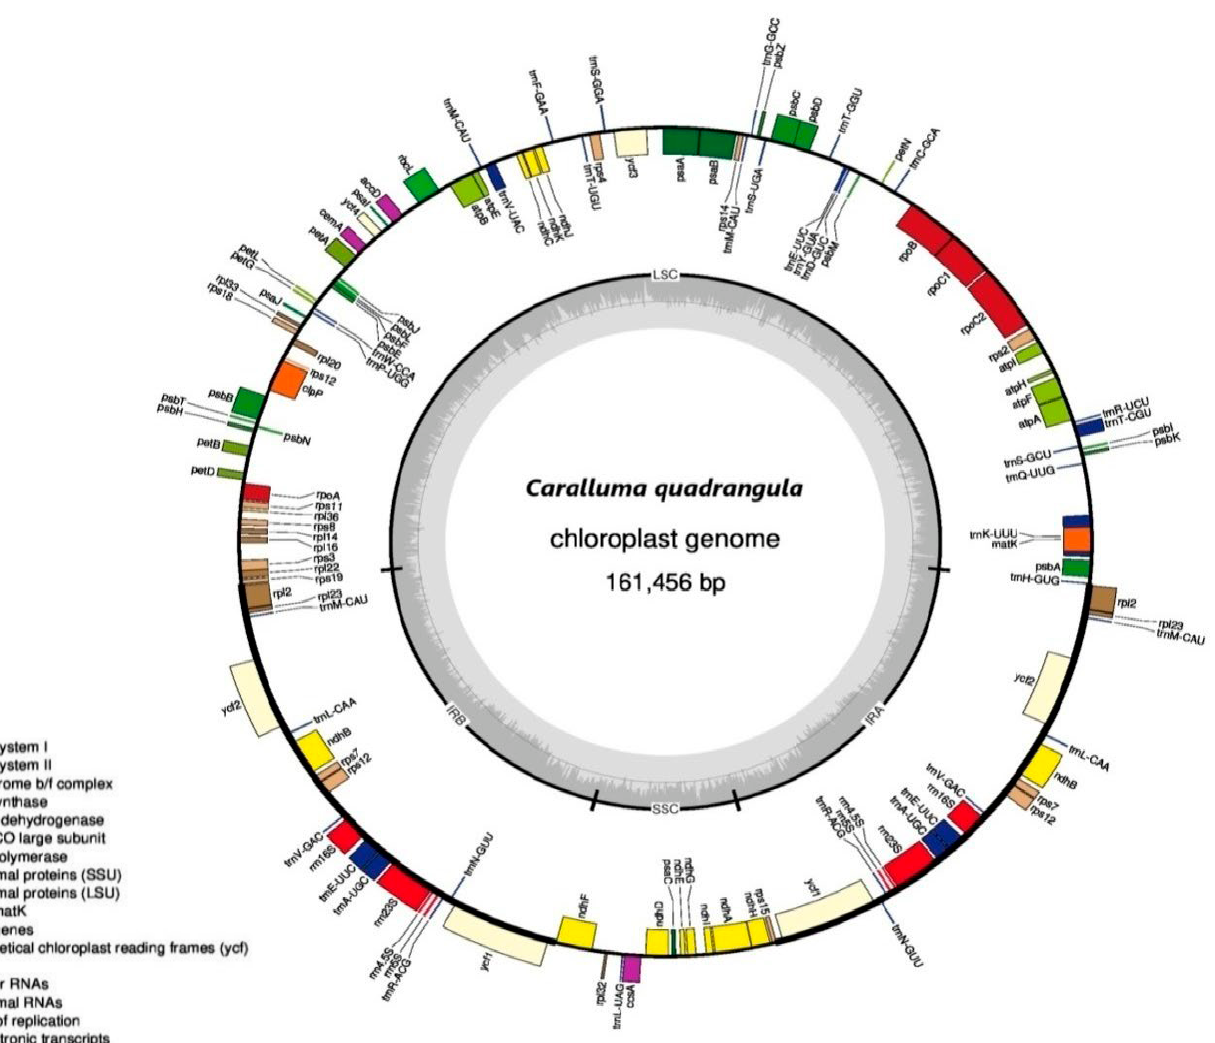
Fig. 2: Cp genome map of Caralluma quadrangula : Genes on the outside are pulling towards the counterclockwise direction, while the inner genes are pull- ing in the clockwise direction. Functional groups are represented with colors. GC content represented by dark portion (slight grey), while AT content is shown in light gray. The LSC, SSC, and IRs are all represented in the